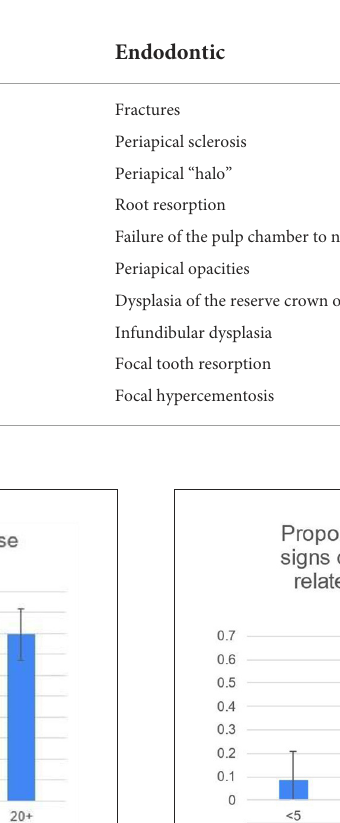
FIGURE2 While the 95% CIs for 20 + and 15–19 overlap slightly, the difference in the percentage of 20 + and 15–19 age groups is significant at the 5% level using the two-sample z-test for difference in